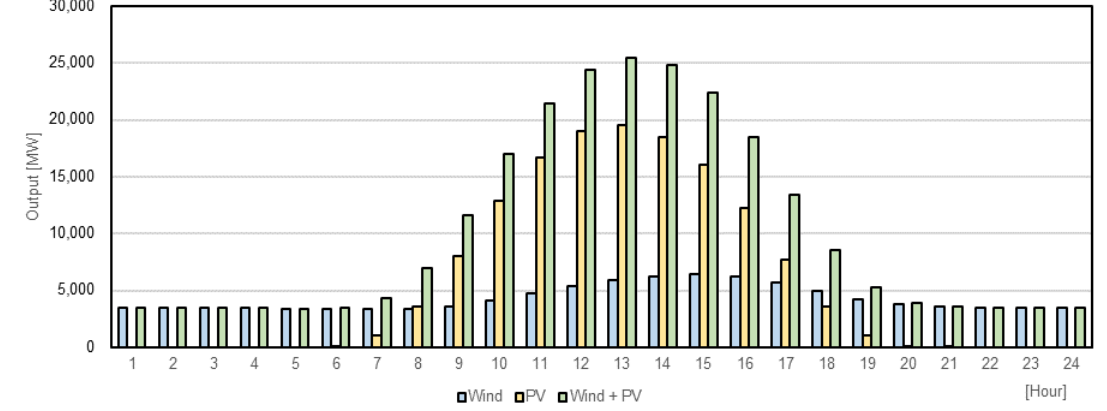
Figure 3. Hourly average output (MW) of wind and PV power projected for 2030. Figure 3 . Hourly average output (MW) of wind and PV power projected for 2030.